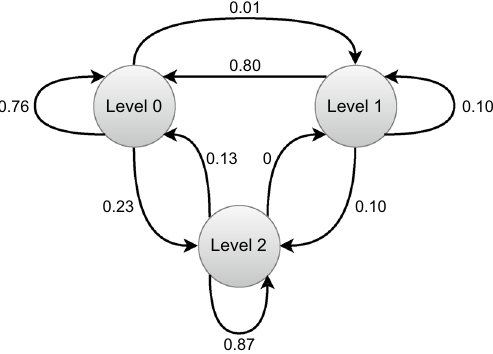
Figure 14. The figure illustrates the transition probability of agent M30. Each node represents the asserted regulation. The agent recommends level-2 restrictions instead of level-0 and level-1 restrictions. The agent almost ignores level-1 regulations in the decision